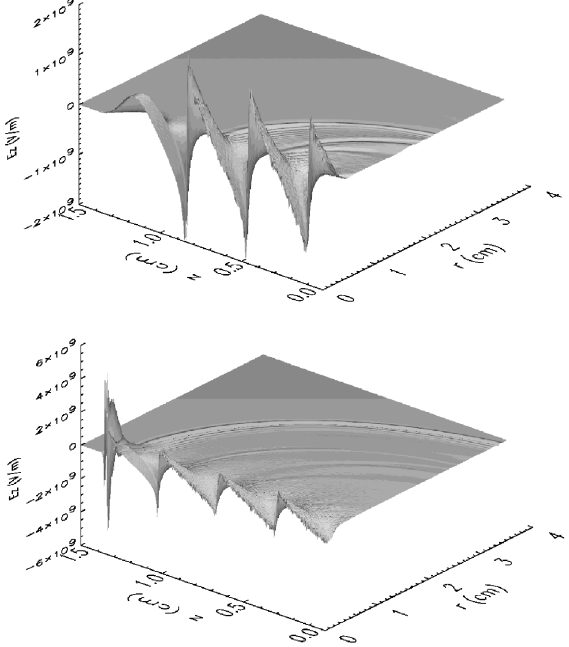
FIG. 9. Surface plot of E in OOPIC PWFA simulation with z ~ QQ (cid:4) 20 , (a) long-beam geometry, as in Fig. 8, and (b) ultrashort beam geometry, as in Fig. [Fig. 9(a)] as in the simulations of Fig. 8 (similar to Fig. 2),